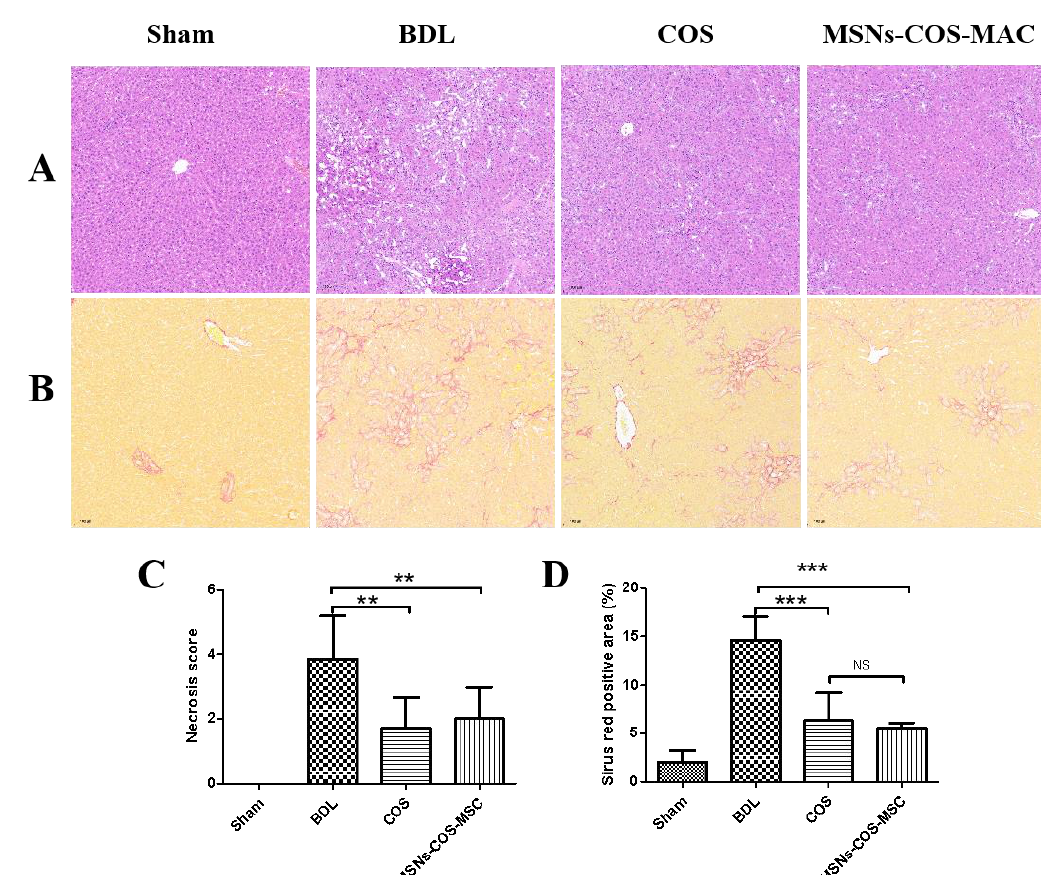
Figure 8. MSNs-COS-MAC improved liver fibrosis in BDL rats. ( A ) Liver pathological changes were detected by H&E staining. ( B ) The degree of liver collagen accumulation was determined by Sirius Red staining. ( C ) A blinded quantitative assessment hepatic necrosis score. ( D ) The percentage of Sirius Red positively stained areas. ** p < 0.01 and *** p < 0.001, significantly different from the BDL group.